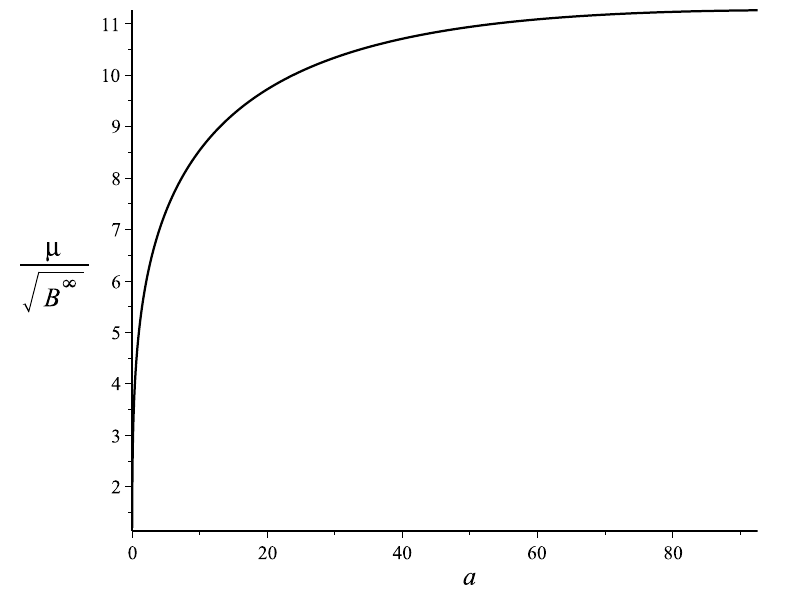
√ Figure 7 . µ/ B ∞ as a function of a , for L = 100 (Planck units). The upper bound is ≈ 11 . 3 in this